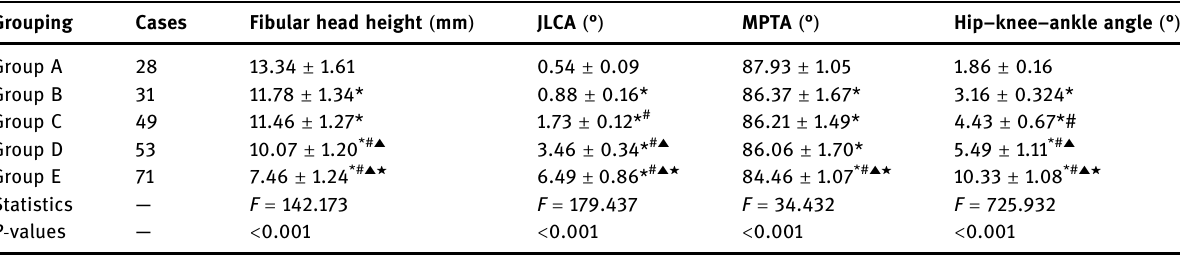
Table 2: Comparison of imaging measurement indicators between di ff erent groups Grouping